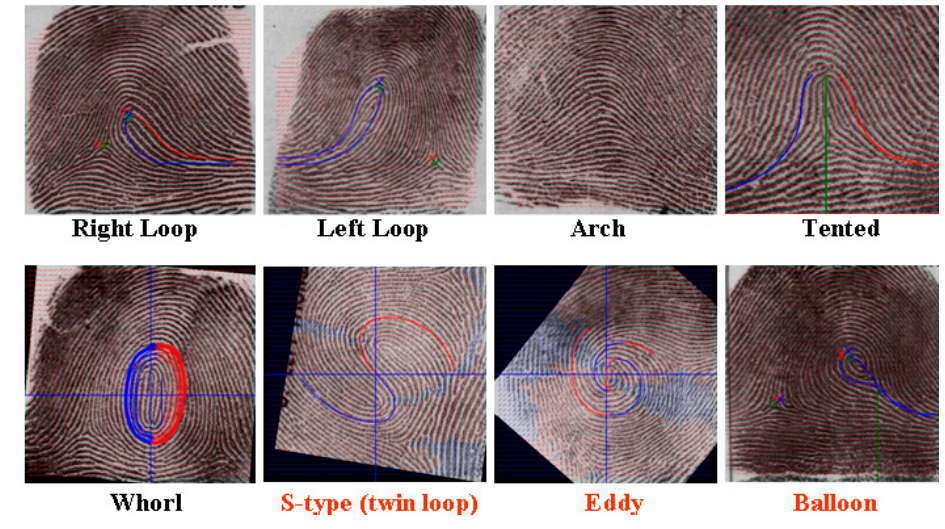
Figure 2. The eight fingerprint types.